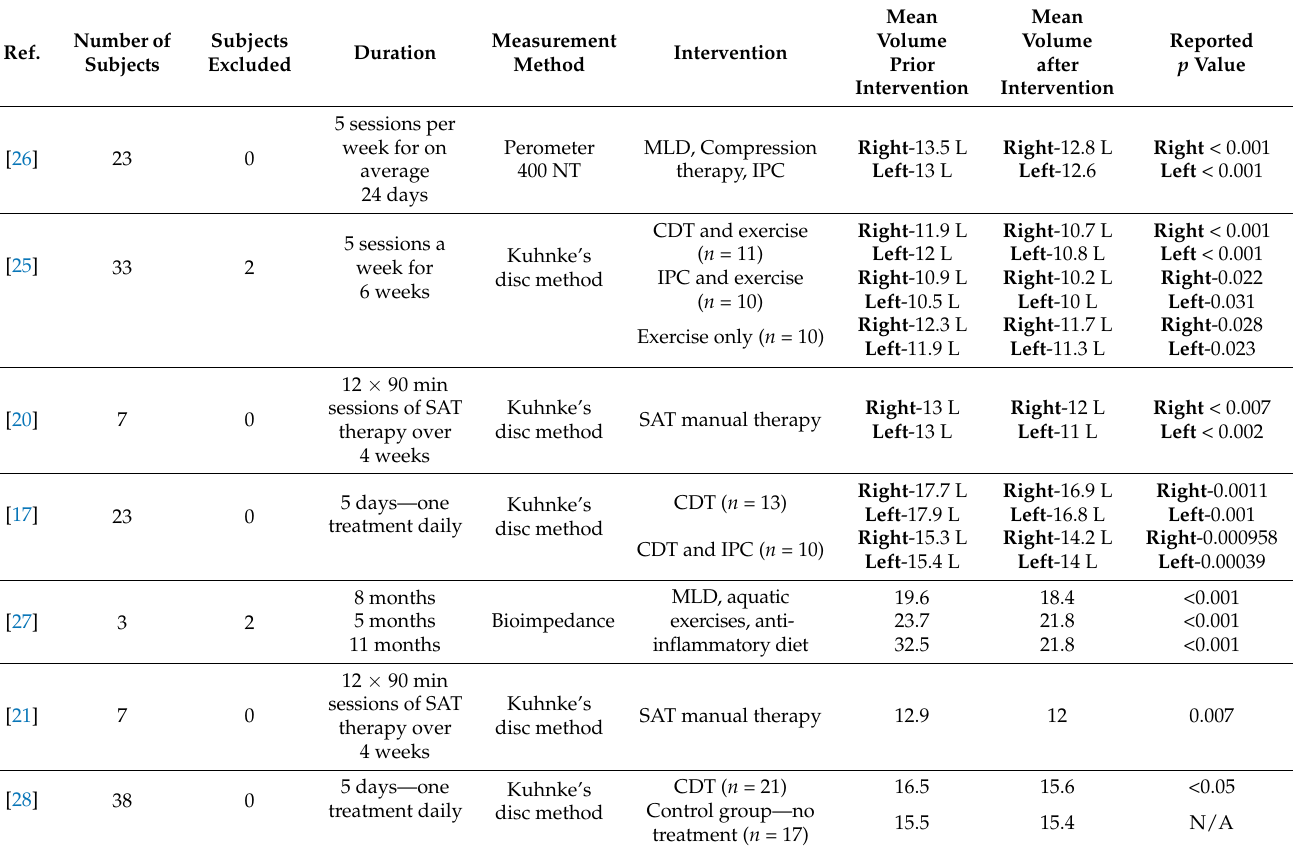
Table 2. The effects of complete decongestive therapy (CDT) in lipoedema treatment assessed by volume